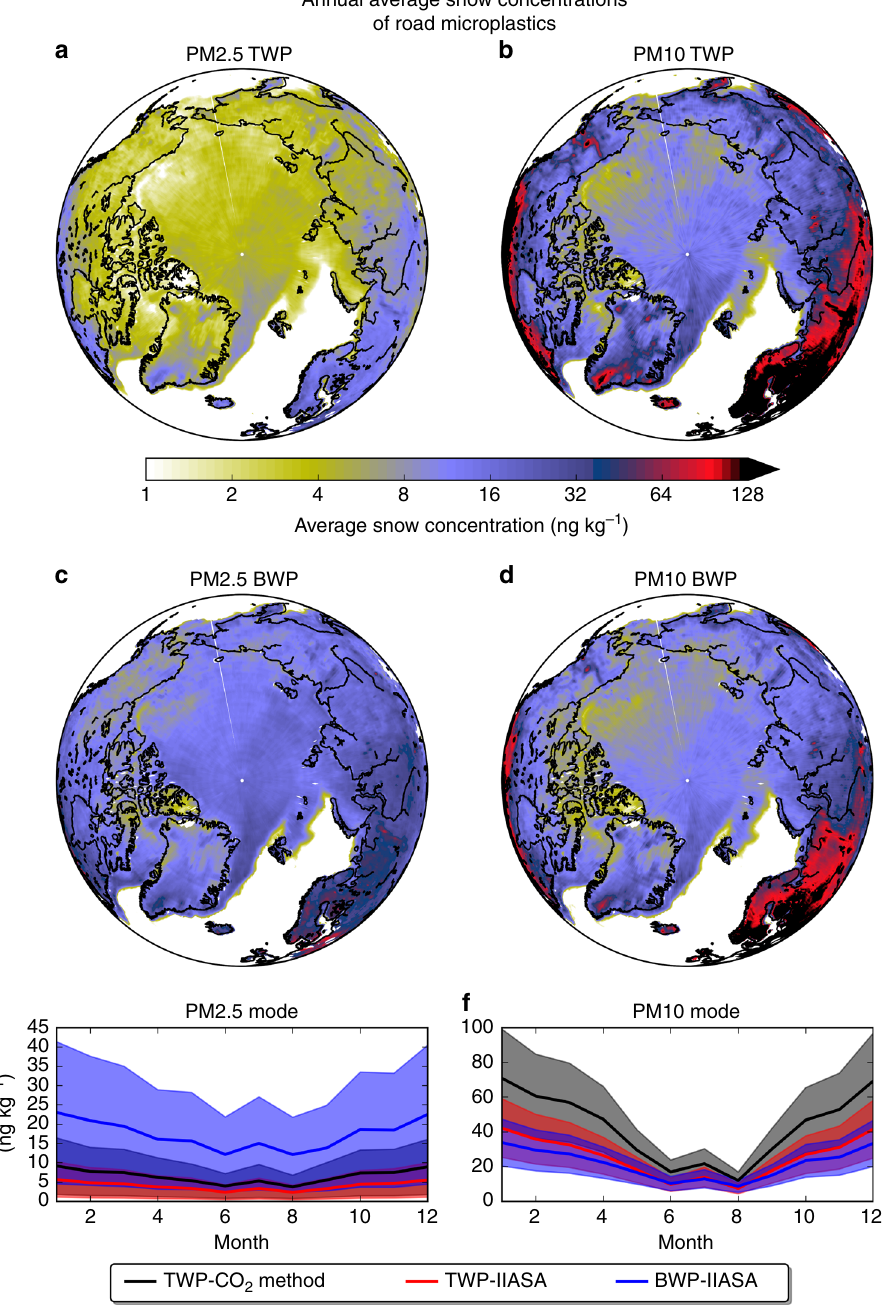
Fig. 3 Road microplastics in snow and ice. Annual average concentrations of road microplastics in Arctic snow ( a – d ) in ngkg − 1 . Snow concentrations were calculated using daily fi elds of sea-ice area fraction and total snowfall from European Centre for Medium-Range Weather Forecast (ECMWF) combined with daily modelled deposition. The latter includes results from 120 simulations that accounted for different airborne fractions ( fi ve members for each of the PM2.5 and PM10 fractions), particle size distribution (eight members for each of the PM2.5 and PM10 fractions) and CCN/IN (cloud condensation nuclei/ice nuclei) ef fi ciency (three different sets of scavenging coef fi cients per fraction) following a log-normal distribution (see “ Methods ” ). Monthly variation of concentrations of road microplastics in the Arctic snow in both sizes (PM2.5 and PM10) are presented in ( e , f ). For the latter, model results using emissions from both methods are presented. Tyre wear particles (TWPs) and brake wear particles (BWPs) uncertainties have been calculated as the geometric standard deviation of all the 120 simulations with different assumption (airborne fraction, size distribution and CCN/IN ef fi ciency, see “ Methods ” ). Note that the smallest concentrations occur in mid-summer ( e , f